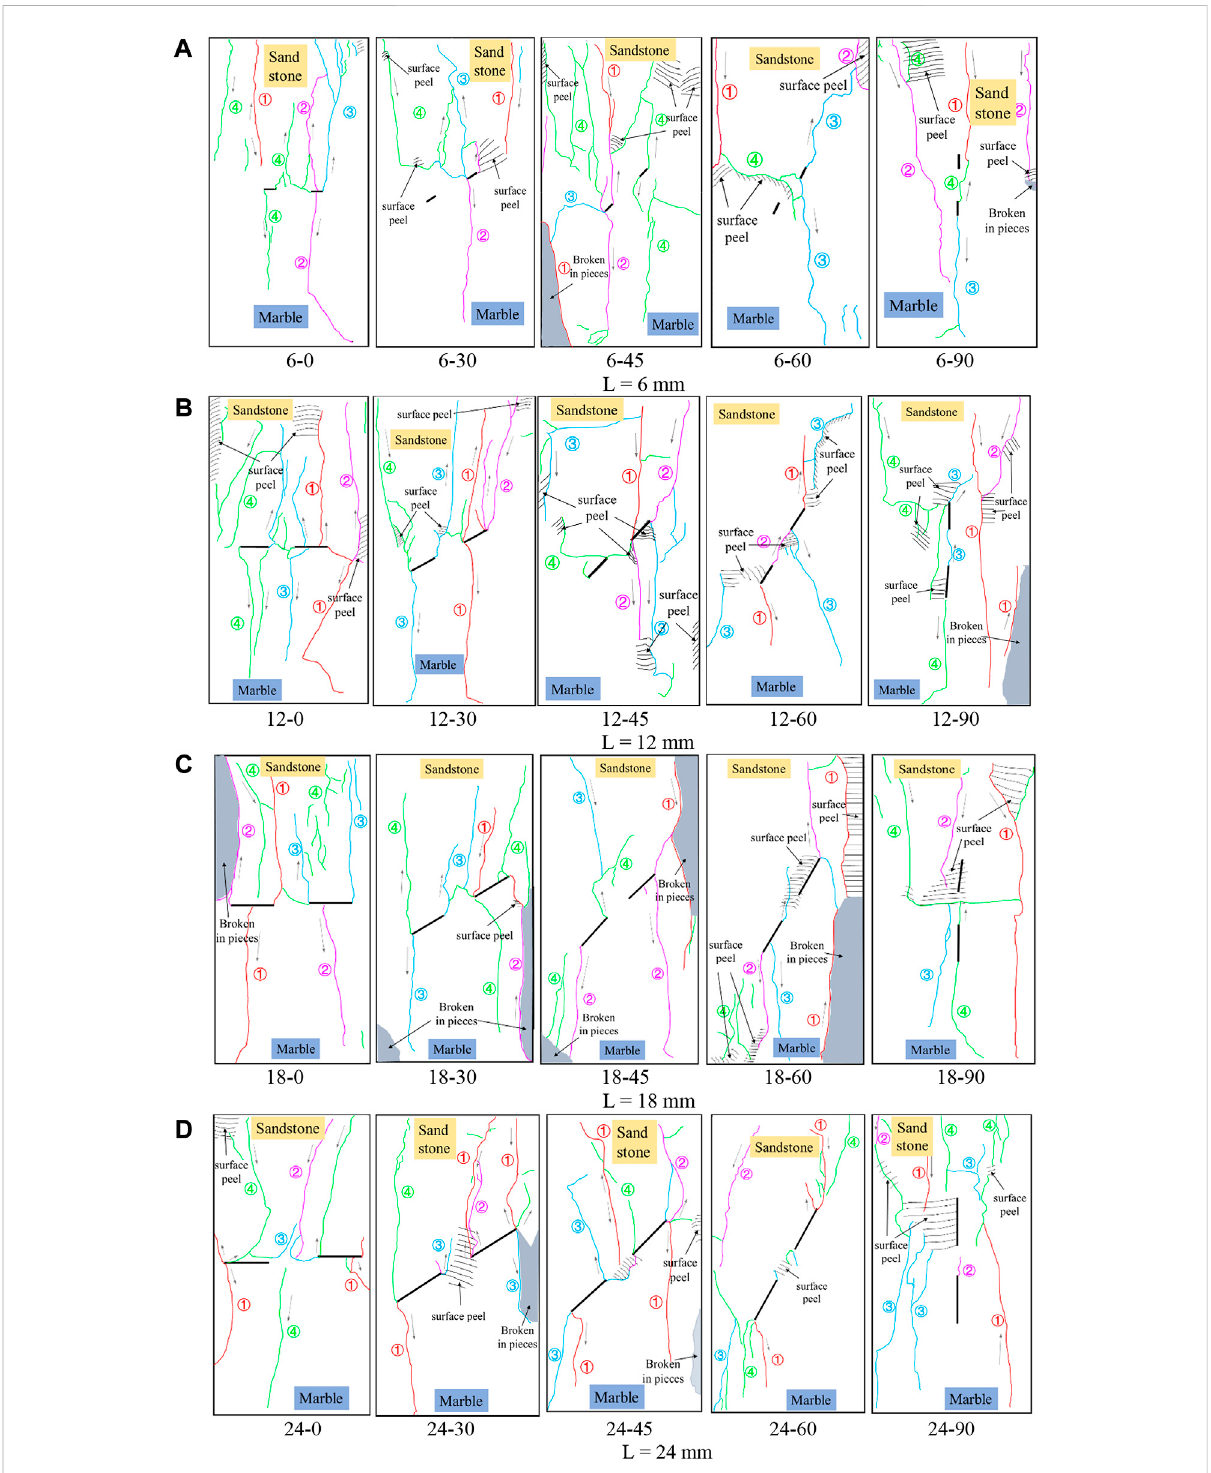
FIGURE 11 Variation in failure characteristics of rock samples with fracture angle under different fracture lengths. 6-0, 6-30, 6-45, 6-60, 6-90 (A) L = 6 mm. 12-0, 12-30, 12-45, 12-60, 12-90 (B) L = 12 mm. 18-0, 18-30, 18-45, 18-60, 18-90 (C) L = 18 mm. 24-0, 24-30, 24-45, 24-60, 24-90 (D) L = 24